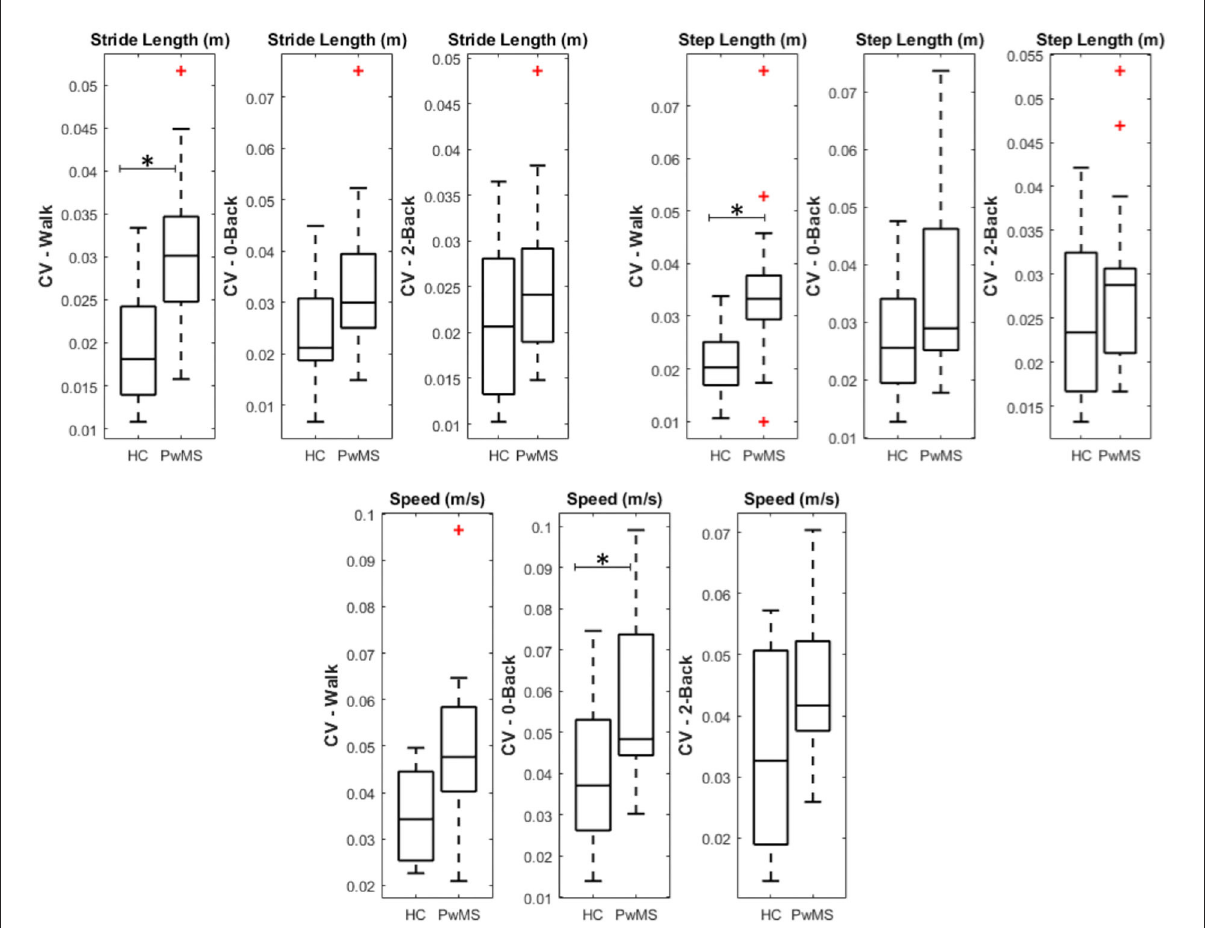
FIGURE5 Boxplot of the significant parameters in group comparison after multi-comparison correction (* p <